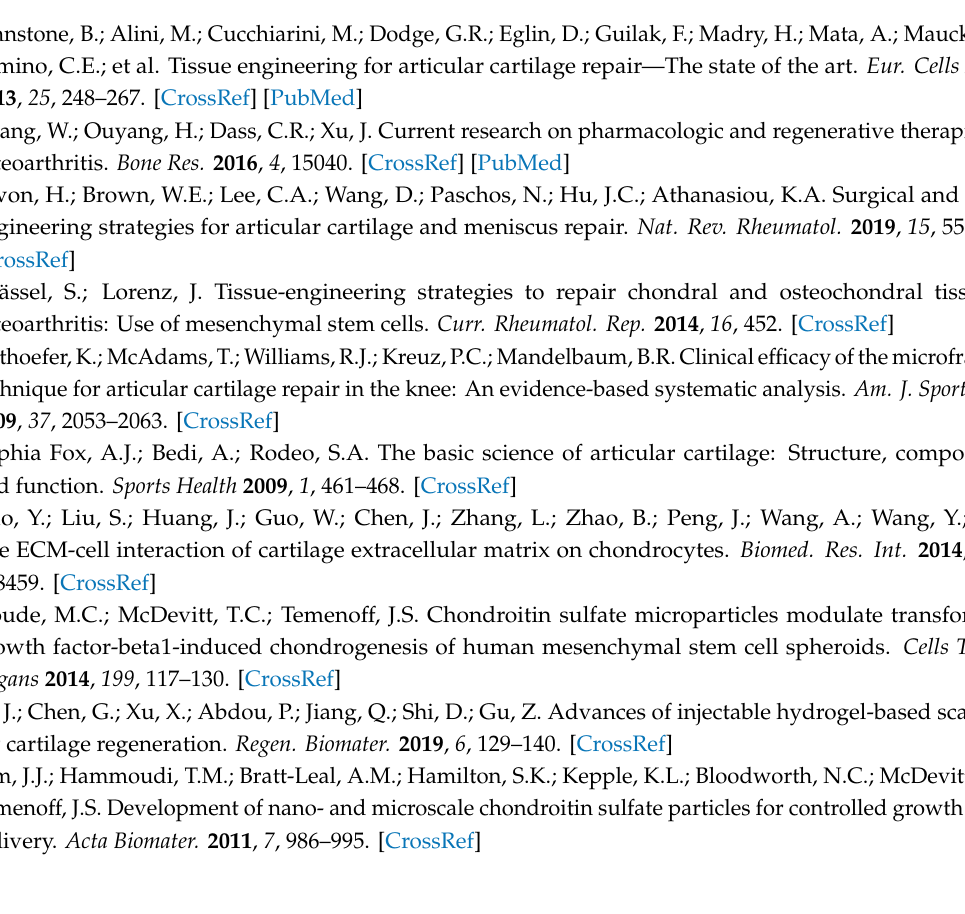
Figure S1: 1 H NMR spectrum of molecules in D2O for gelatin., Figure S2: Quantification of gelatin-based molecules with TNBS. (A) Absorption spectra of primary amino group of the gelatin reacted with TNBS at di ff erent concentrations. (B) Characterization of di ff erent degrees of substitution for the gelatin-based molecules., Figure S3: Particle size distribution profile of HA-AGMCs, Table S1: The protons on the primitive gelatin exhibited chemical shift signals from peak 1 to peak 12., Table S2: Characterization of the HA-AGMCs, Table S3: List of genes and the primers used for PCR in